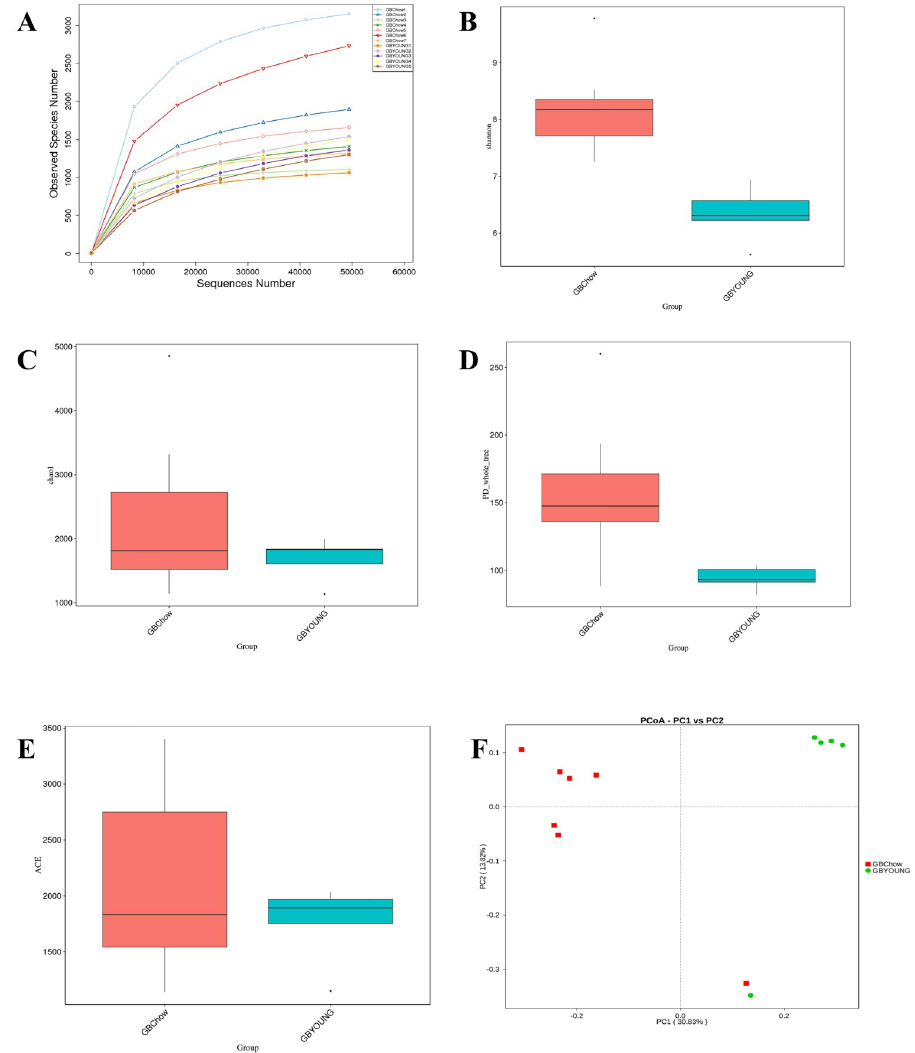
Fig 1. Measures of microbial diversity of gallbladder samples of the 2 age groups. A: Rarefaction curves (at 97% similarity level) of each gallbladder sample. B: Box plot of the Shannon-Weaver index. C: Box plot of the Chao-1 index. D: Box plot of phylogenetic diversity whole tree. E: Box plot of the ACE index. F: Unweighted UniFrac Principal Coordinate Analysis. GBChow: adult healthy rabbits; GBYOUNG: healthy rabbits before weaning.